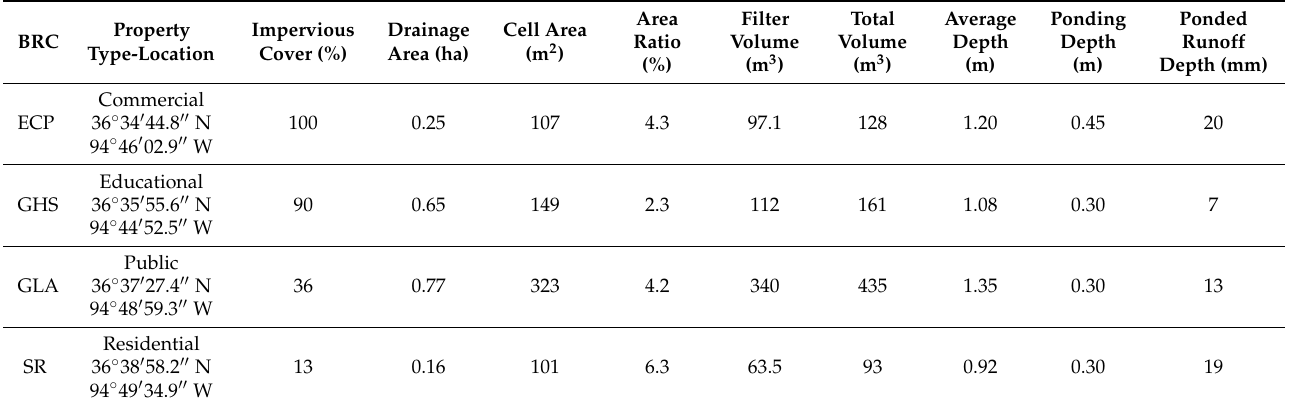
Table 3. BRC locations and physical dimensions for four cells sampled in